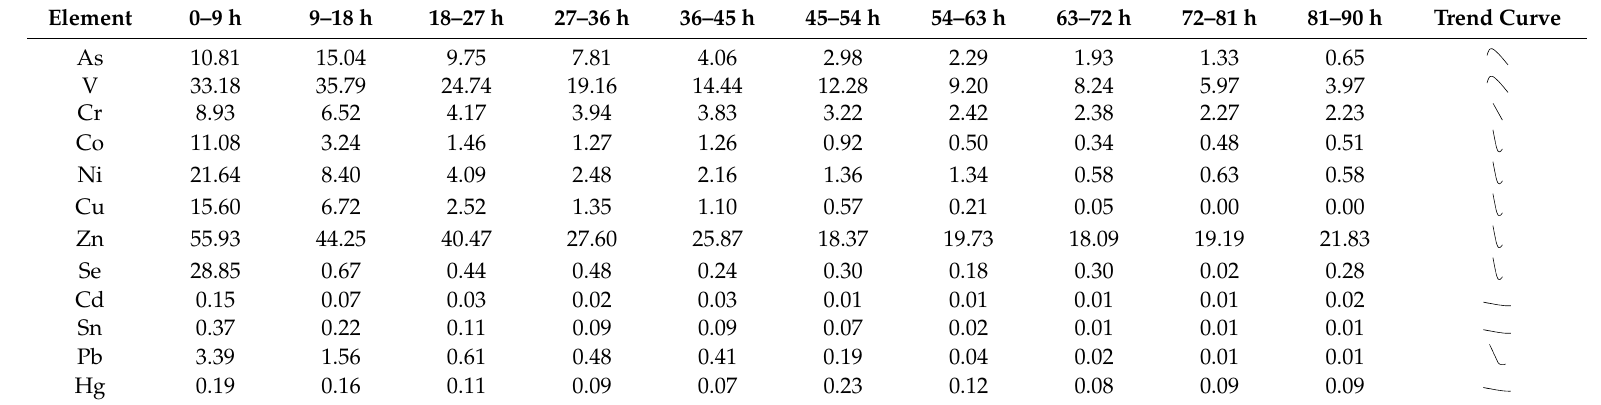
Table 4. Analytical concentrations of the selected trace elements in resulting leachates from 0–90 h in Experiment I ( µ g/L).